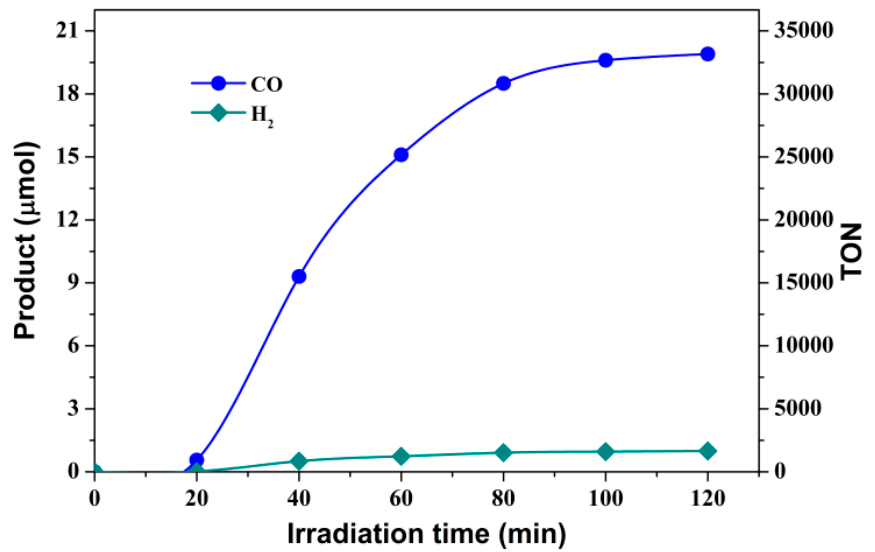
Figure 3. Visible-light-driven production of CO (blue) and H 2 (dark cyan) in 4 mL CO 2 -saturated DMF/TEOA solution (v/v, 7:1) containing 6.7 × 10 − 4 M Ru(bpy) 32+ , 0.022 M BIH and 1.5 × 10 − 7 M Fe(phen) 2 (CH 3 CH 2 OH)Cl + .